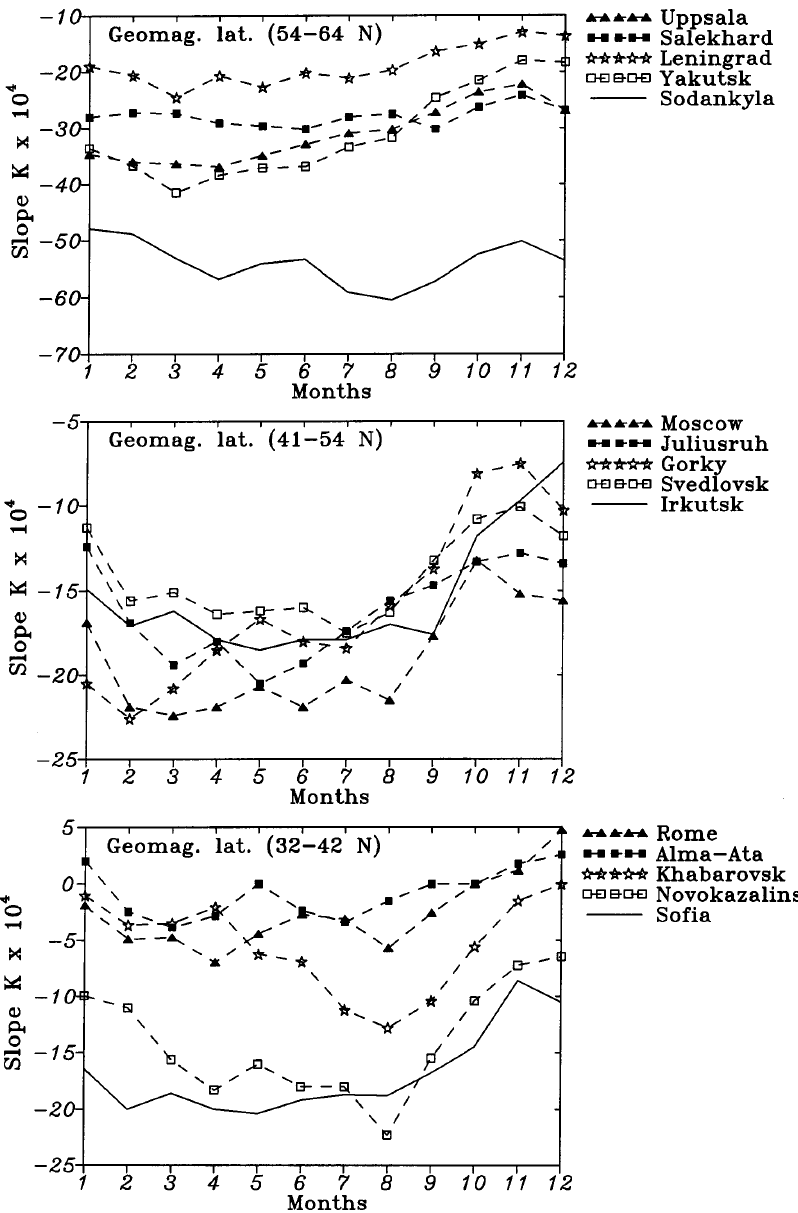
Fig. 3. Annual variations of k for high, middle, and low latitude